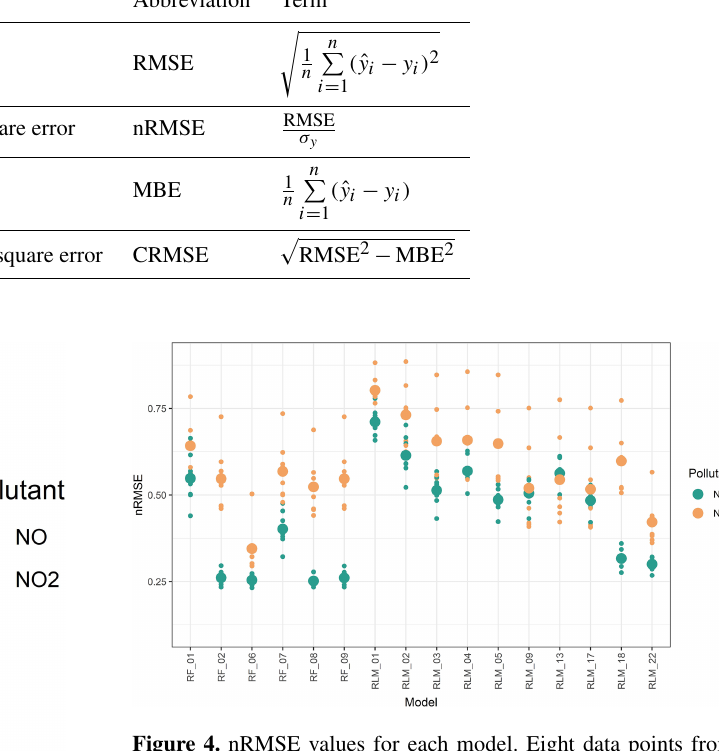
Figure 4. nRMSE values for each model. Eight data points from individual sensors of NO and NO 2 are shown separately, and mean nRMSE values by pollutant are depicted by larger